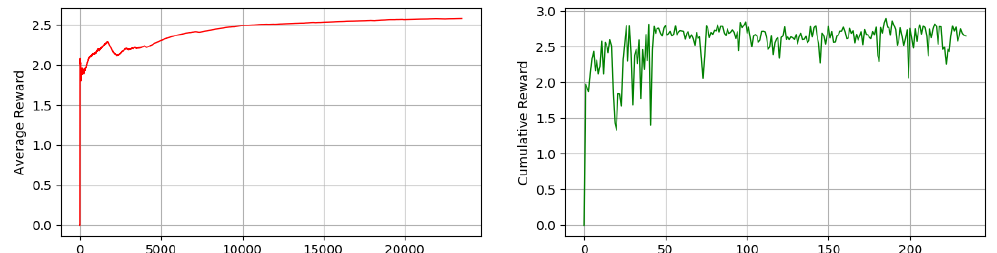
Figure 8. The ( left ) graph shows the average reward that the robot obtains using Deep Actor-Critic (continuous action) over time (showing that robot is able to maximize its average reward). The ( right ) graph shows the cumulative reward that robot accumulate over time and in each episode, the graphs are drawn over (20,000 steps) using no short-term memory.